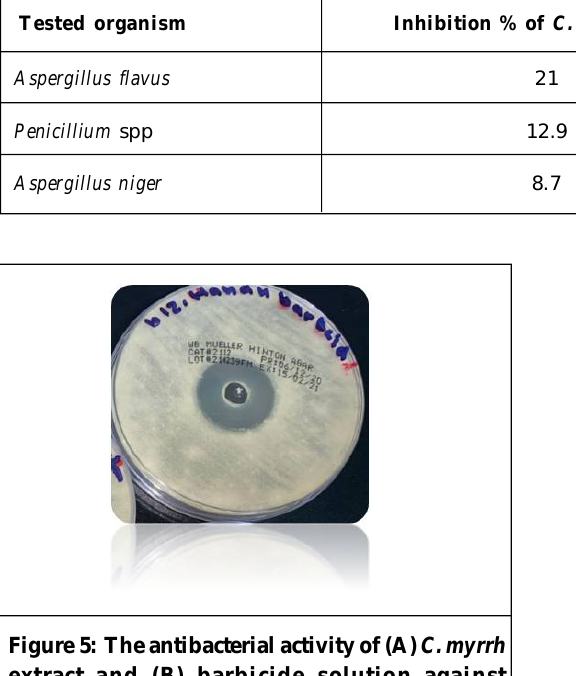
Figure 6: The antibacterial activity of(A) C. myrrh extract and (B) barbicide solution against